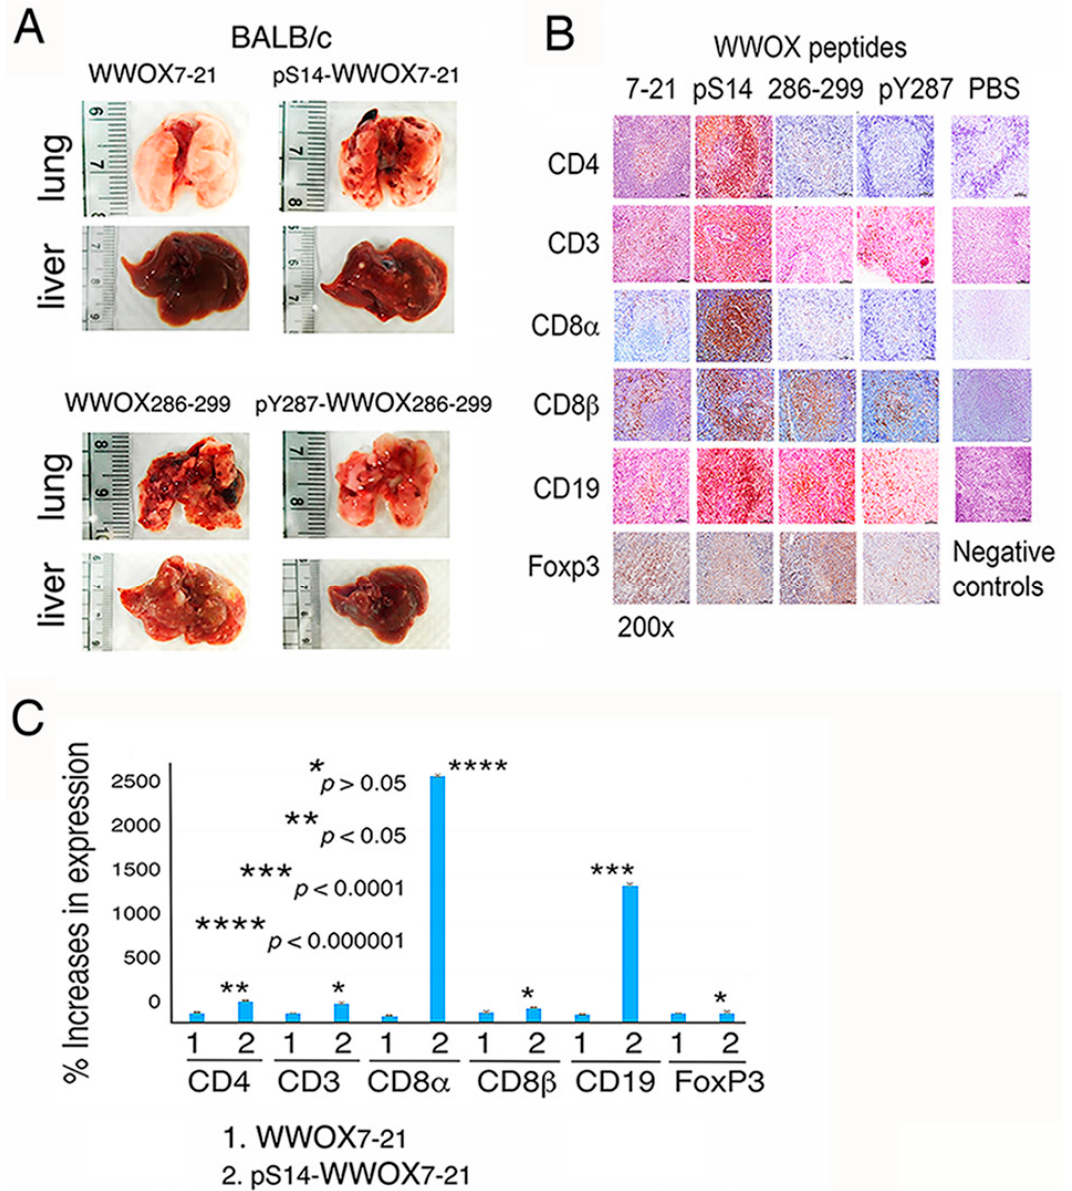
Figure 3. WWOX7-21 peptide suppresses melanoma metastasis, whereas pS14-WWOX7-21 peptide induces cytotoxic T cell expansion and fails to block cancer metastasis in vivo. ( A ) BALB/c mice received subcutaneous injections of WWOX7-21 peptide and became resistant to the metastasis of melanoma B16F10 cells to the lung and liver. Other peptides were ineffective. ( B,C ) pS14-WWOX7-21 peptide significantly induced the expansion of CD4 + and CD8 α + T and CD19 + B cells in the germinal centers, but had no effect on Foxp3 + Treg cells in BALB/c mice. Scale bar = 50 µm.